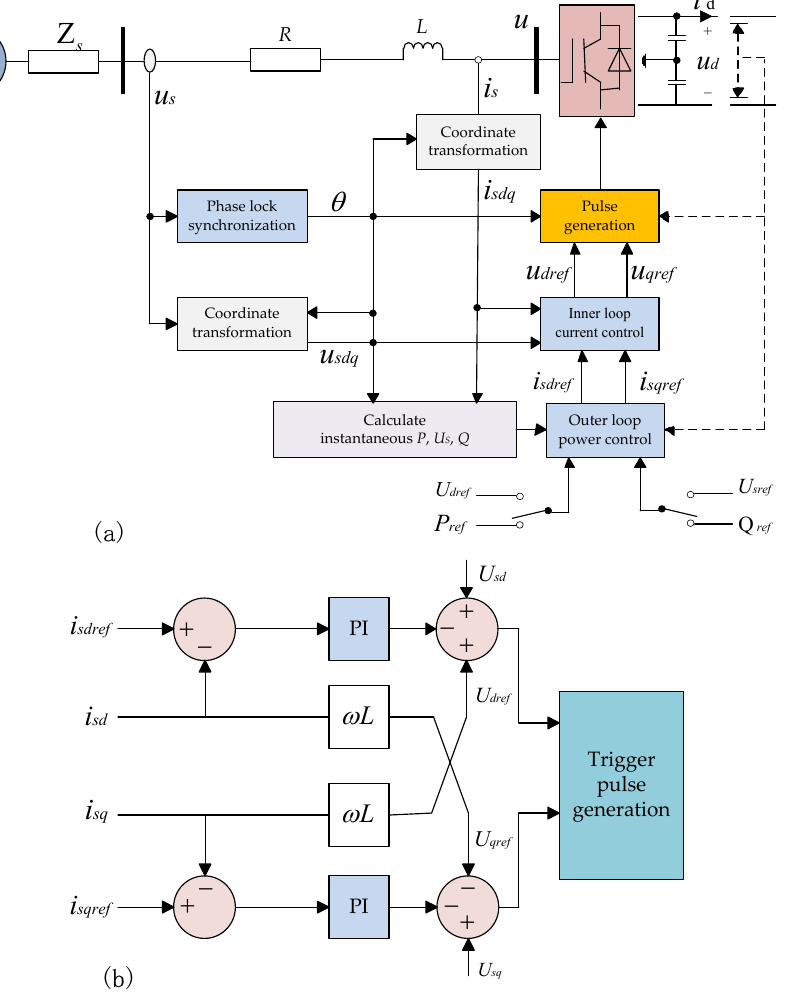
Figure 2. Voltage source converter (VSC) control system structure: ( a ) Overall controller structure and ( b ) Inner loop controller structure.